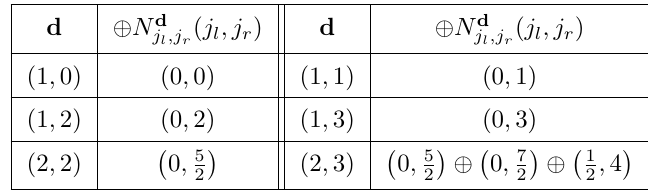
Table 4. BPS spectrum of the SU(2) π theory for d 1 ≤ 2 , d 2 ≤ 3 , where d = ( d 1 , d 2 ) labels the states from an M2-brane wrapping d 1 e + d 2 f curve in F 1